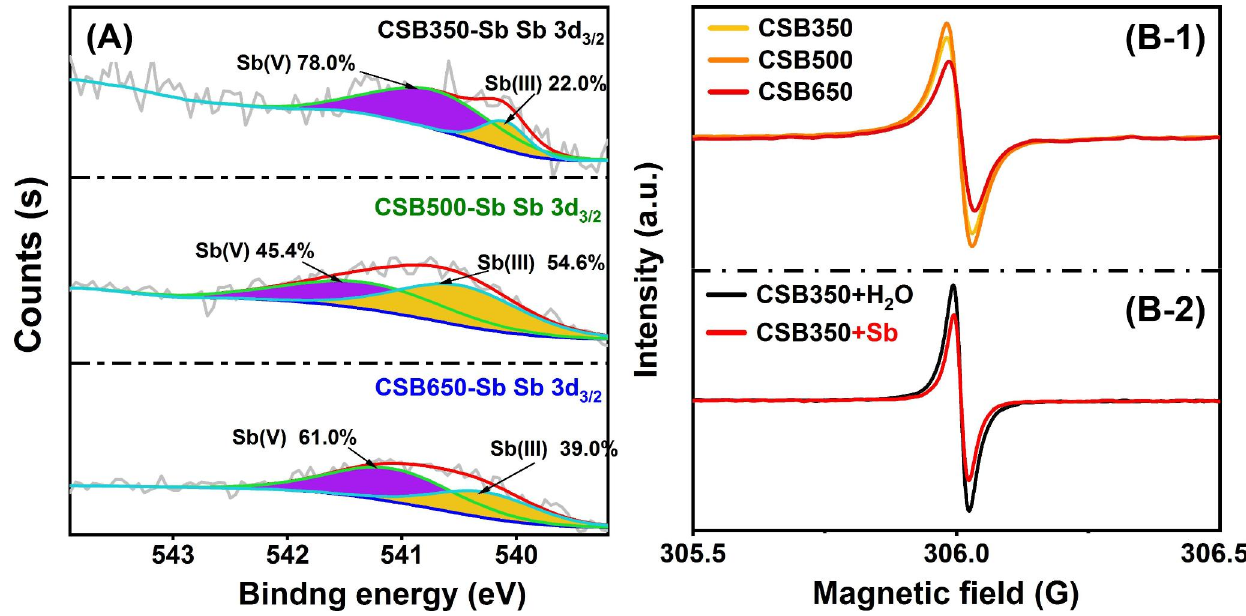
° C (CSB350), 500 ° C (CSB500), and 650 ° C